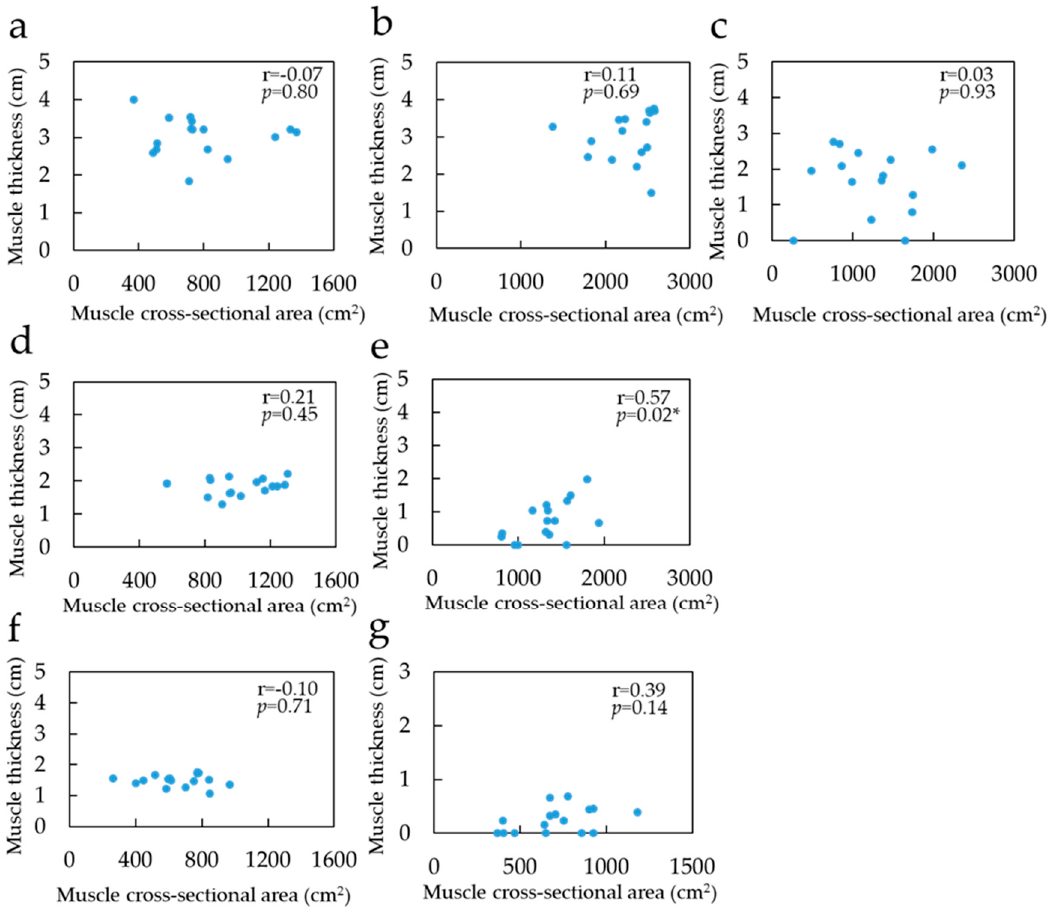
Figure 5. Correlation coefficient between muscle cross-sectional area in sitting position and muscle